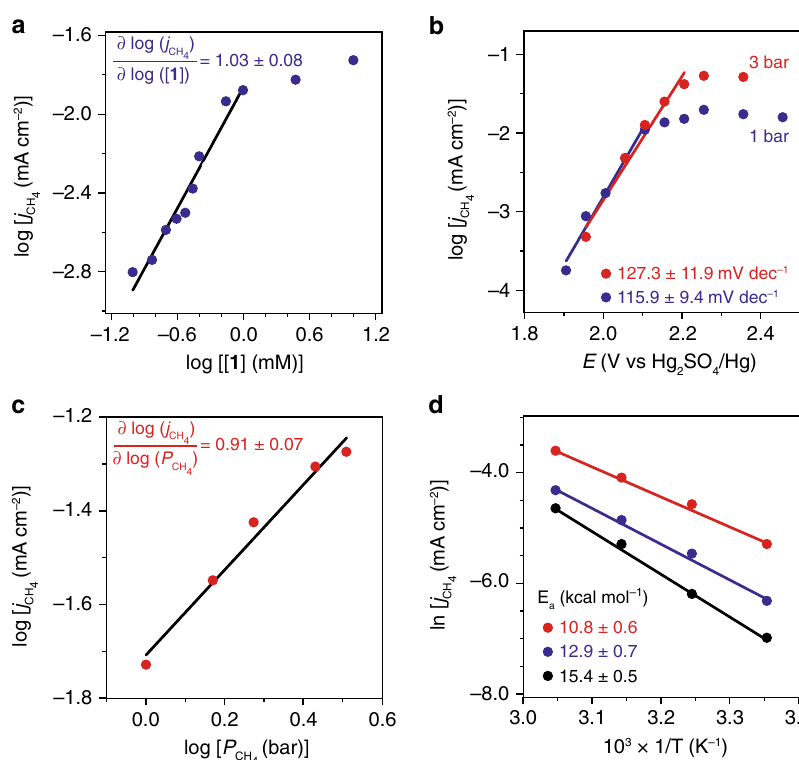
Fig. 3 Electrocatalytic kinetics. a The logarithmic of partial current density for CH 4 functionalization, log( j CH4 ), versus the logarithmic of 1 ’ s concentration, log([ 1 ]). b Log( j CH4 ) vs. E under CH 4 pressures of 1 bar (blue) and 3 bar (red) with the fi tted Tafel slopes displayed. c Log( j CH4 ) vs. the logarithmic of CH 4 pressure, log( p CH4 ). d The natural logarithmic of partial current density for CH 4 functionalization, ln( j CH4 ), vs. inverse of temperature, T − 1 , at 1.955 V (black), 2.005V (blue), and 2.055 V (red) vs. Hg 2 SO 4 /Hg, respectively. The corresponding apparent activation energies ( E a ) are displayed. Unless noted speci fi cally, 25 °C, 10 mM 1 in 98% H 2 SO 4 , E = 2.255 V vs. Hg 2 SO 4 /Hg, p CH4 = 1 bar, data recorded from 6-h bulk